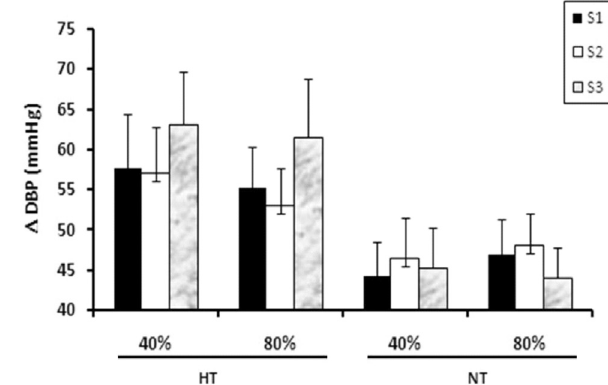
Figure 4 - Diastolic blood pressure (DBP) responses, expressed as the value during a set minus the pre-exercise value ( D DBP), during each of three sets (S1, S2, and S3) of knee extension resistance exercises performed to exhaus- tion at 40% and 80% of 1RM (repetition maximum) in hypertensive (HT) subjects and normotensive (NT)